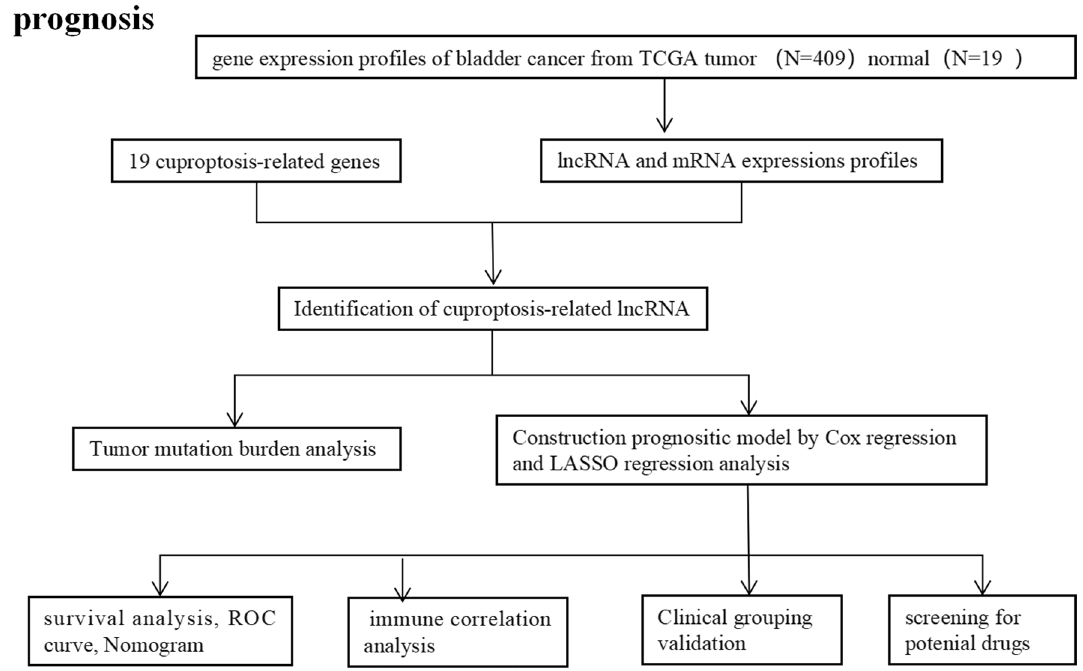
Fig. 1 The flowchart of the overall procedures. This flowchart illustrates the process of data collection and analysis for prognostic